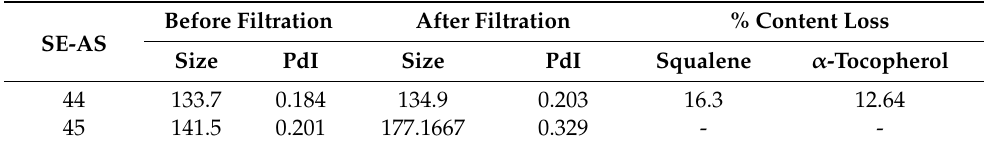
Table 2. Size, PdI and percent content loss pre- and post-filtration for SE-AS44 and 45. Before Filtration After Filtration % Content Loss SE-AS Size PdI Size